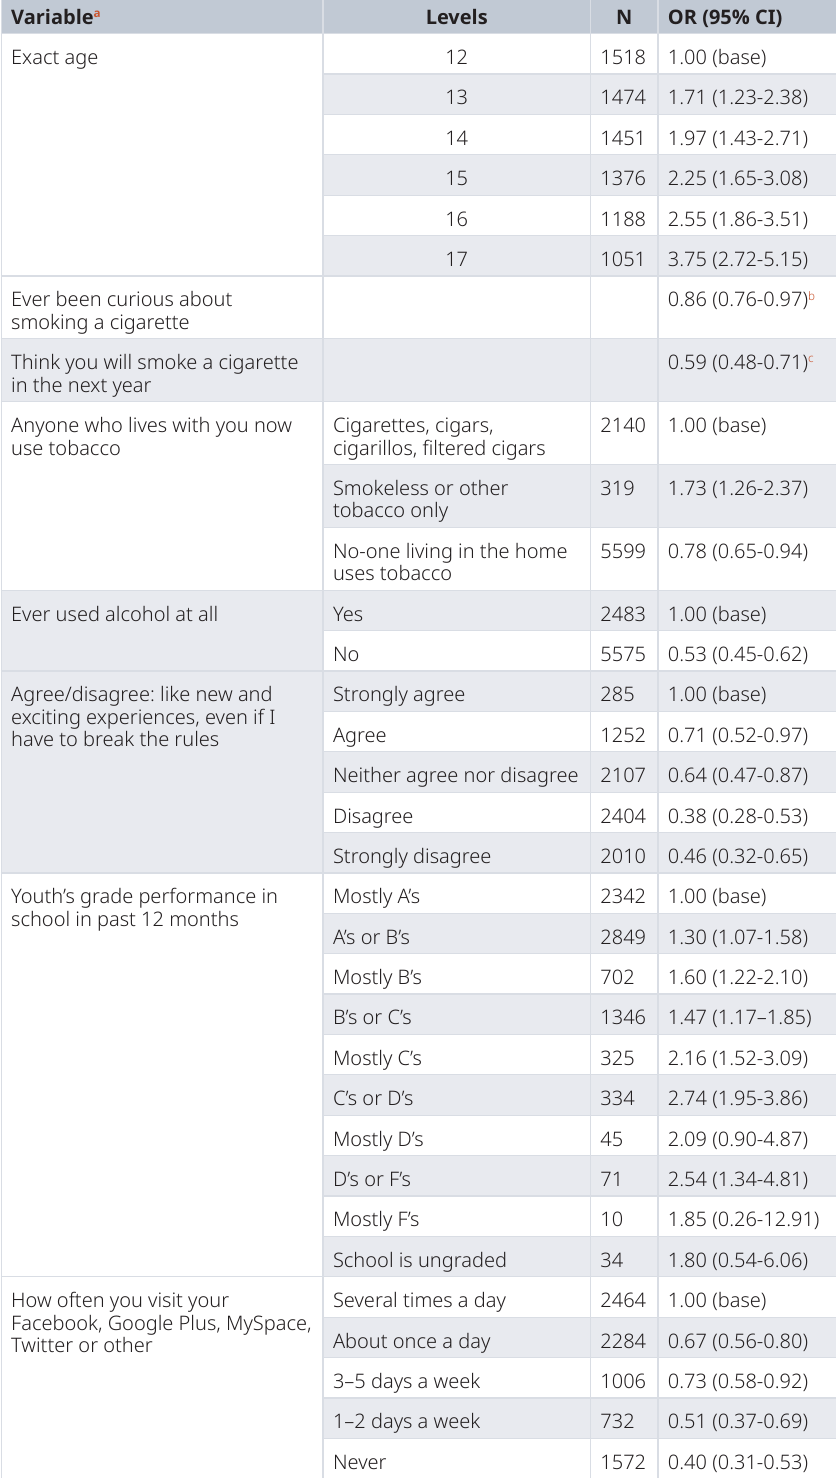
Table 1. Predicting Wave 2 ever e-product use from 16 Wave 1 predictor variables (Main analysis